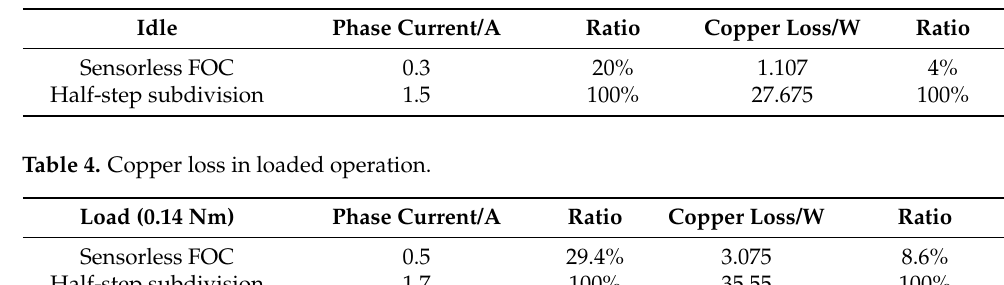
subdivision mode; ( b ) 120 rpm SPL under sensorless FOC mode.